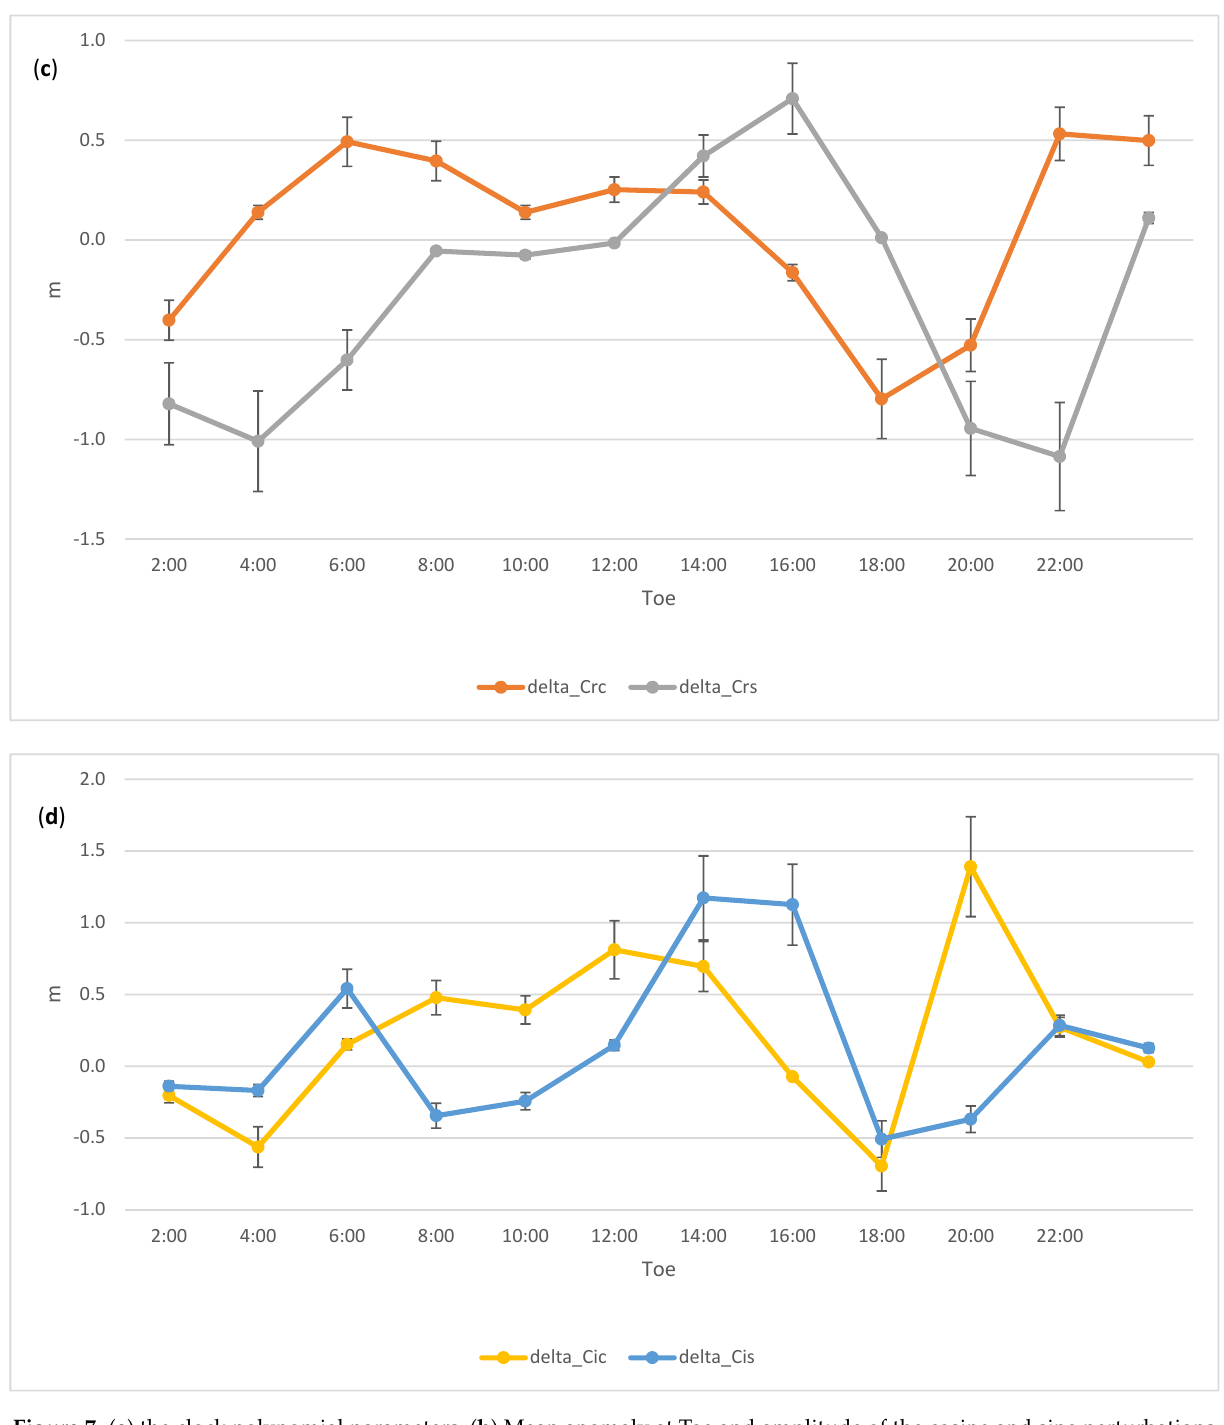
Figure 7. ( a ) the clock polynomial parameters, ( b ) Mean anomaly at Toe and amplitude of the cosine and sine perturbations along track due to the second zonal harmonic (Cuc, Cus), and amplitude of the cosine and sine perturbations in the ( c ) radial (Crc, Crs) and ( d ) cross track (Cic, Cis) directions. To convert to radians the scale factor 42 × 10 6 m should be used. Error bars are 1 sigma formal uncertainties. Satellite C07 for day 2 January 2020.